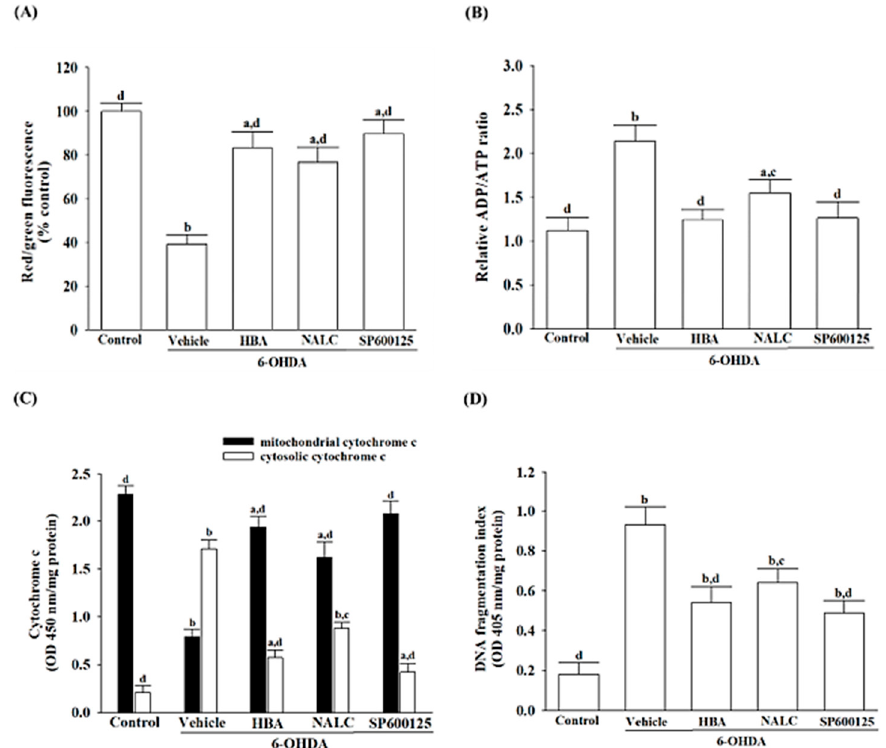
Figure 3. HBA reduces SH-SY5Y cells of 6-OHDA-induced mitochondrial dysfunction.